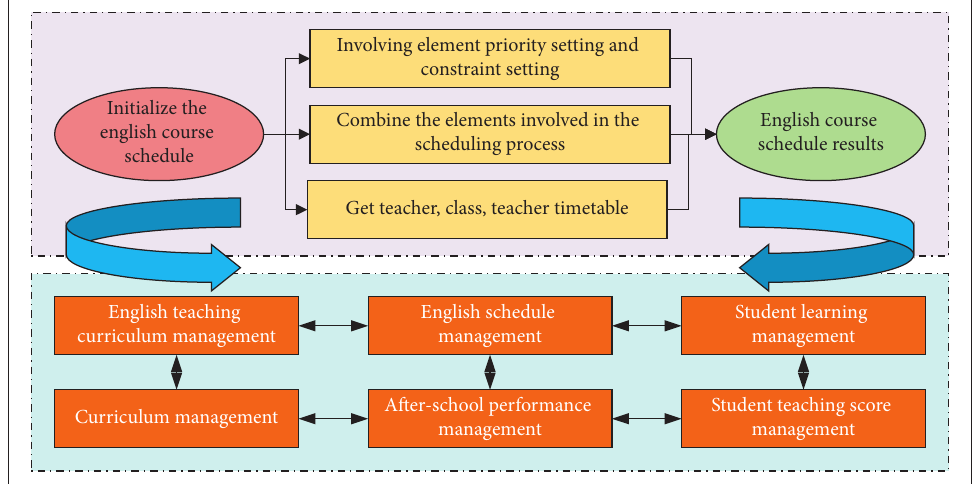
Figure 3: Experimental